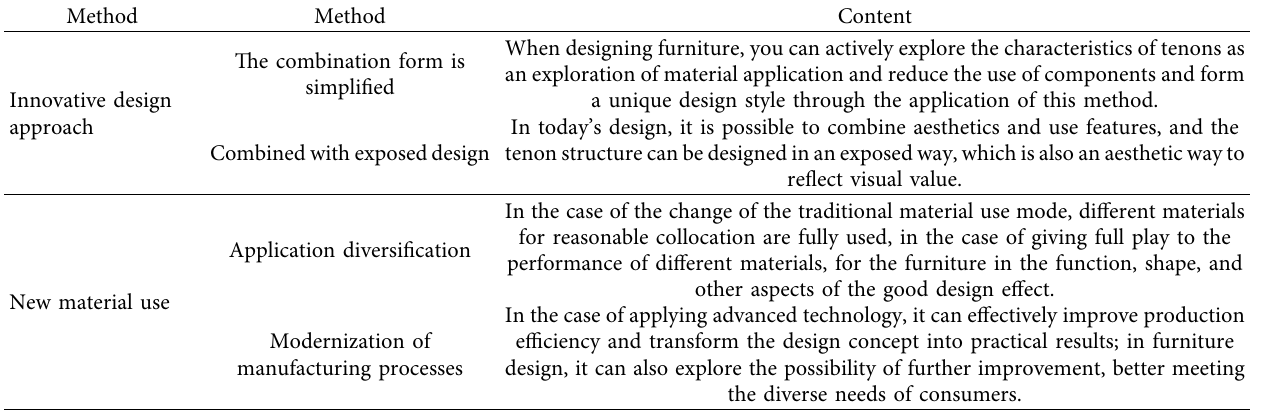
Table 2: Tenon structure furniture